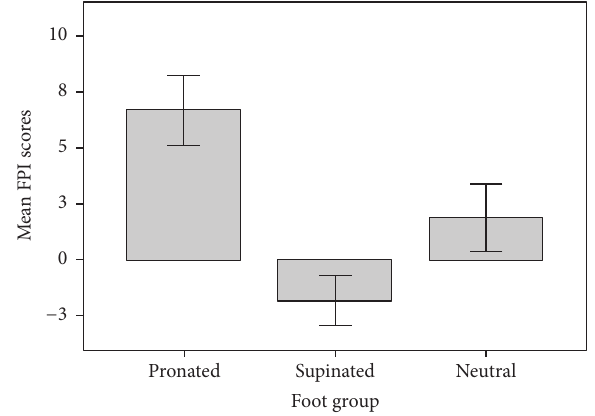
Figure 2: Error bars (+/ − 1 SD) for FPI scores in different types of foot, showing no overlapping of mean scores within neutral, pronated, or supinated foot group. (FPI: Foot Posture